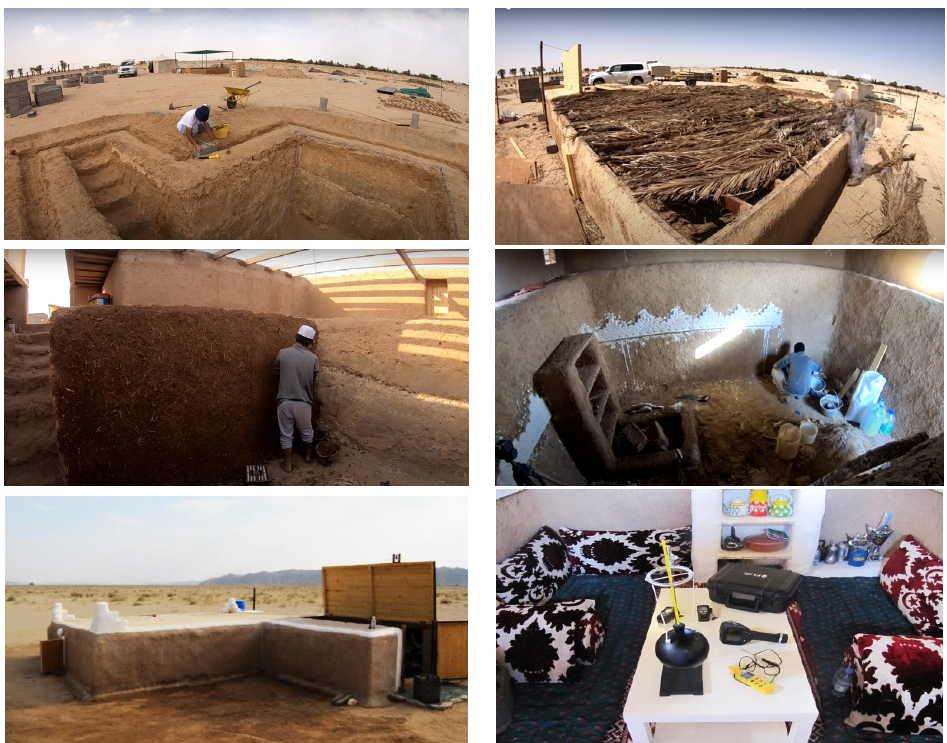
Figure 4. Site construction of an underground room from digging through to the finishing, in ad- dition to the set-up of the equipment in the underground